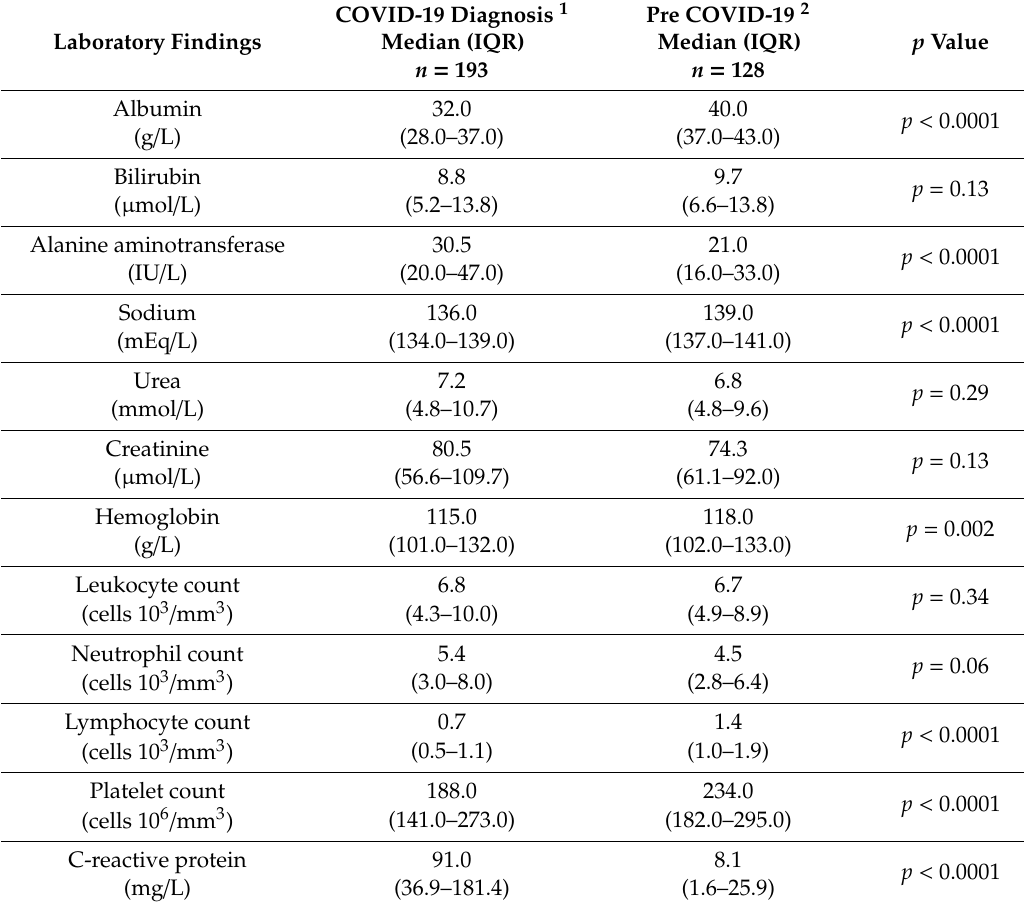
Table 2. Routine laboratory investigations at COVID-19 diagnosis and at last oncological